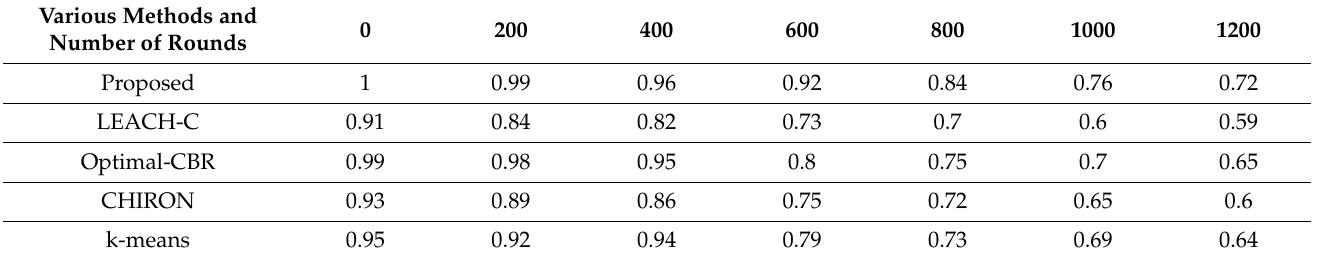
Table 2. Differentiation of the average of residual energy along with the score of rounds in various